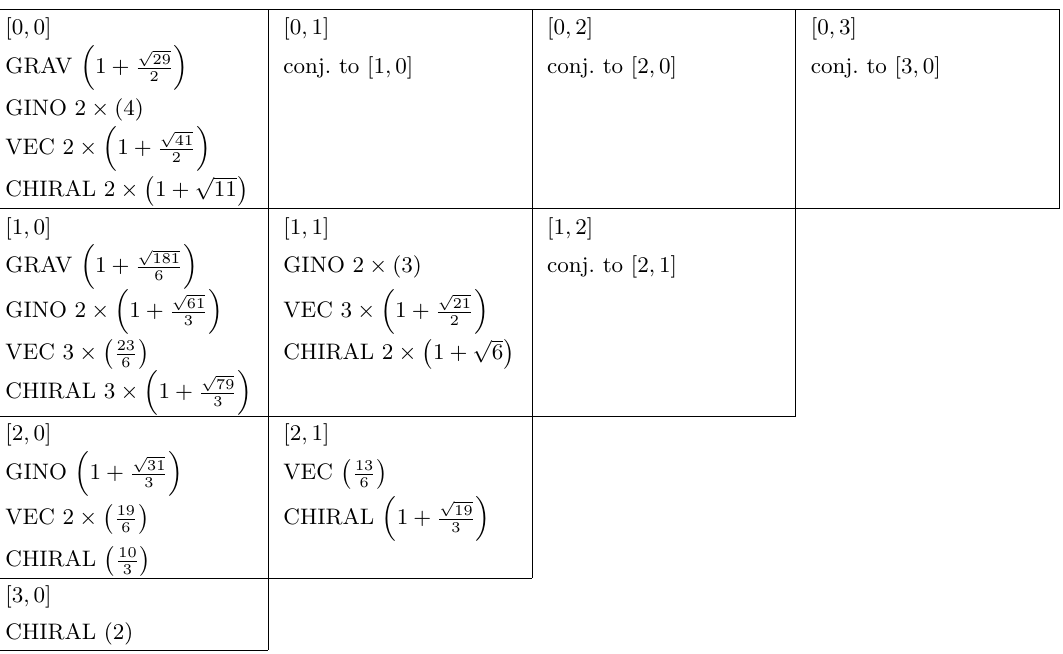
Table 13 . Supermultiplets at KK level n = 1 for the N = 1 SU(3)-invariant AdS 4 solution of type